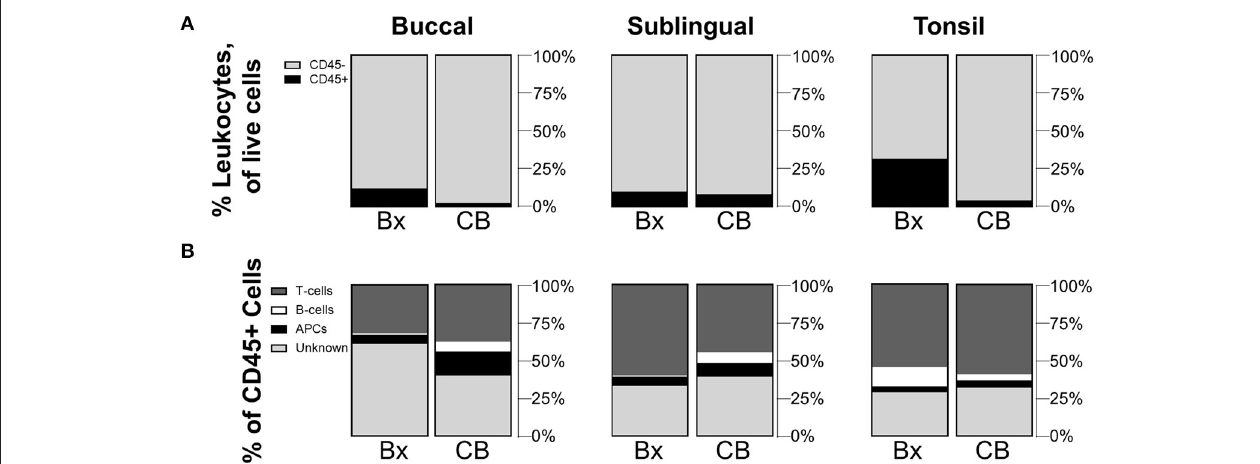
FIGURE 2 | Cytobrushes yield lower frequencies of leukocytes than buccal and tonsil biopsies but show comparable distributions of CD45 + subpopulations. Compositions of (A) CD45 + /– cells in total live cells and (B) subpopulations of CD45 + cells are shown by comparison between biopsy (Bx) and cytobrush (CB). Mean values of cell frequencies are used to show compositions, with n = 4–7 NHPs. T-cells are defined to be CD45 + CD3 + , B-cells as CD45 + CD3–CD20 + , APCs as CD45 + CD3–CD20–CD11c + , and unknown immune cells are CD45 +